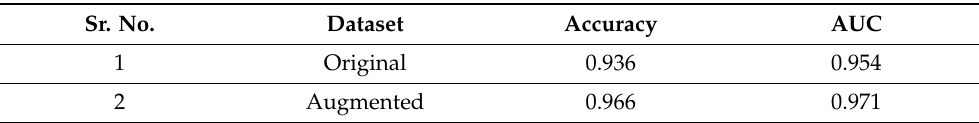
Table 6. The performance comparison of the proposed model and different existing transfer learning models on an original and augmented dataset. Sr. No.